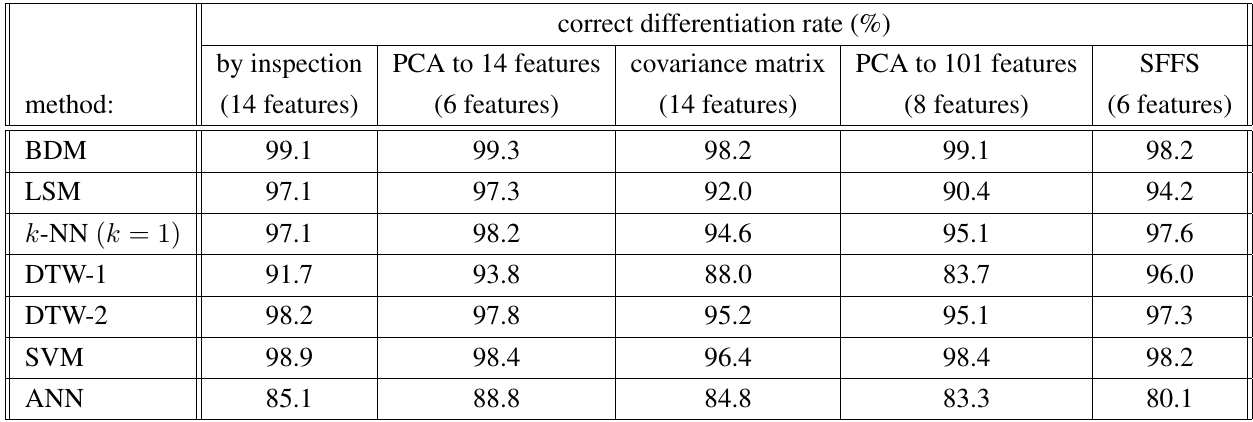
Table 5. Correct differentiation rates for different feature reduction methods and LOO cross